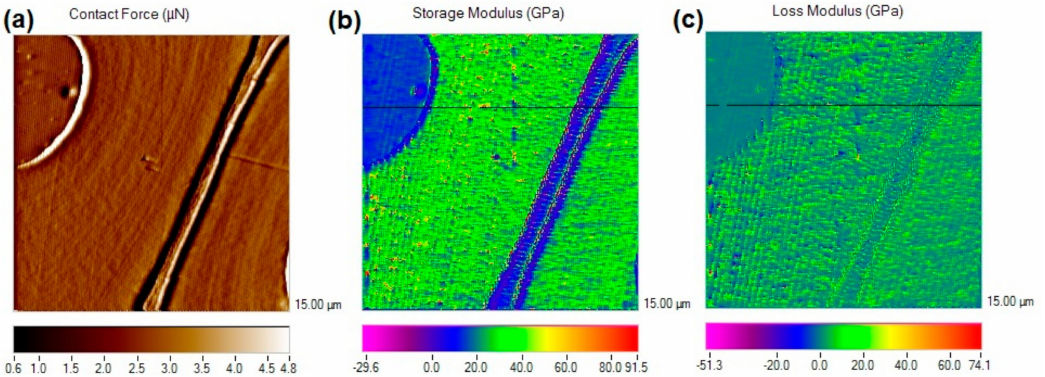
Figure 9. Modulus mapping of PF-modified wood tracheids: ( a ) Contact force image; ( b ) Storage modulus image; ( c ) Loss modulus